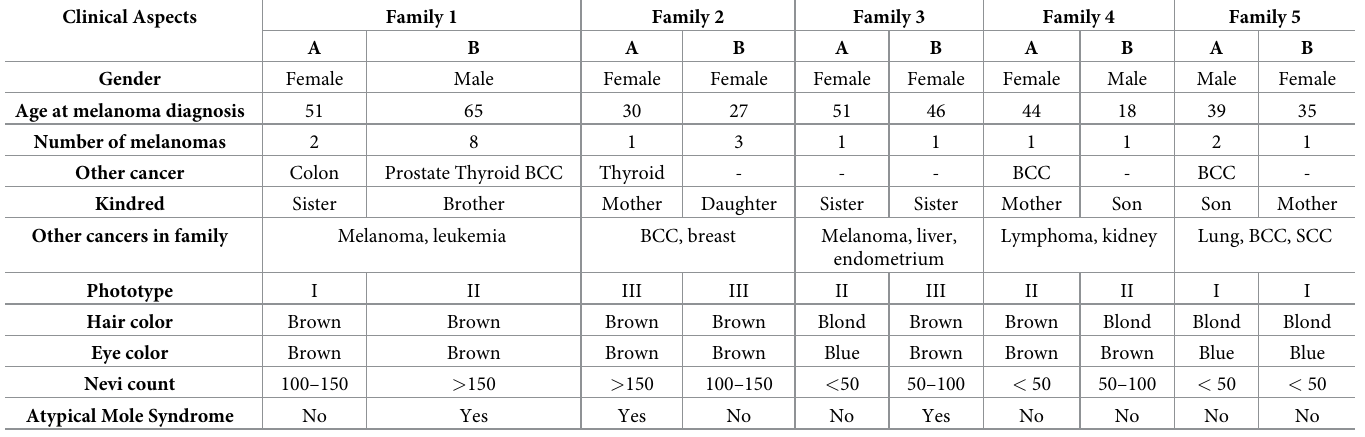
Table 1. Clinical characteristics of cutaneous melanoma patients.